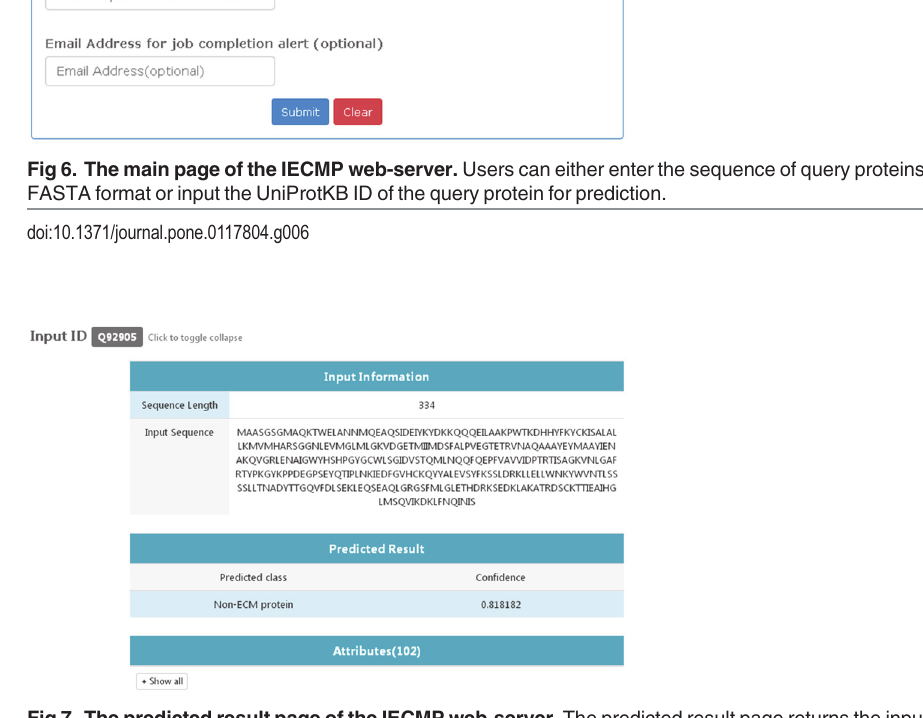
Fig 7. The predicted result page of the IECMP web-server. The predicted result page returns the input information, predicted result, and values of attributes for every submitted sequence.